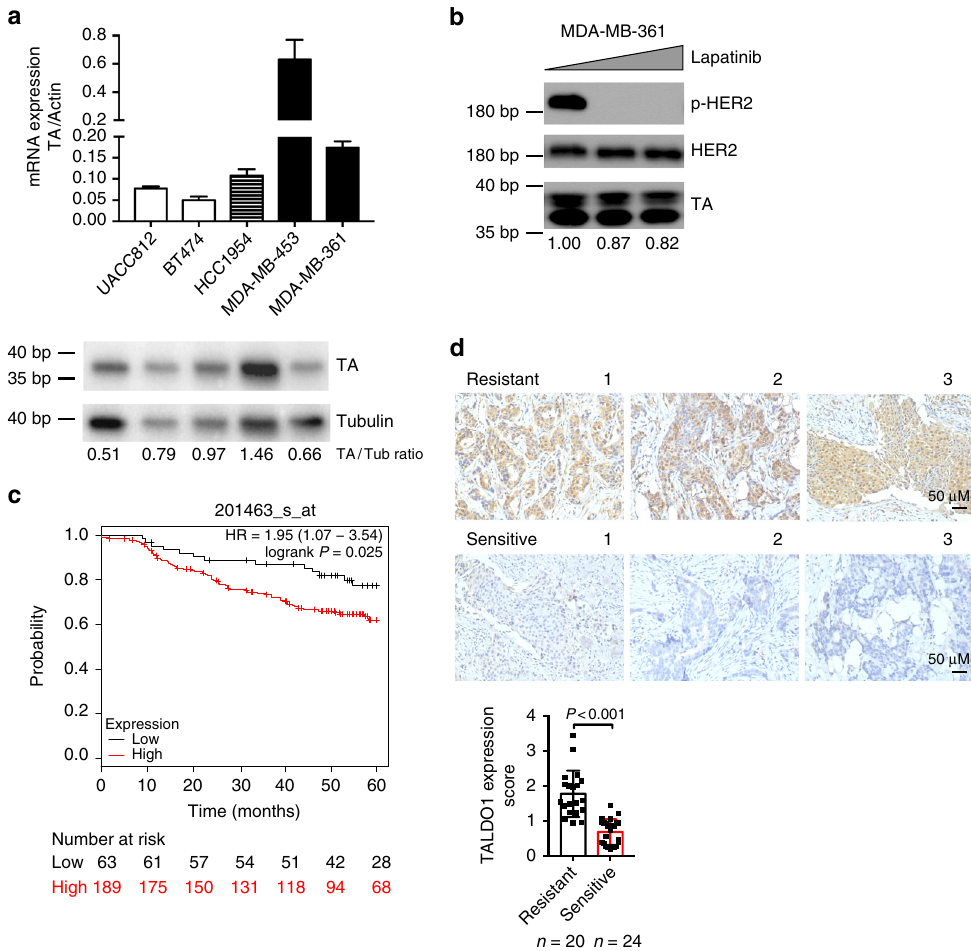
Fig. 3 TA expression correlates with sensitivity to lapatinib. a TA mRNA expression (normalized to actin, top) and protein expression (normalized to tubulin, bottom) of the indicated breast cancer cell lines was evaluated by RT-qPCR and western blotting, respectively. b Immunoblotting with indicated antibodies. MDA-MB-361 cells were treated with 0, 1, or 3 μ M lapatinib for 72 h and then collected. Band density was quanti fi ed using FIJI. c Kaplan – Meier relapse-free survival (RFS) analysis of HER2-ampli fi ed breast cancer patients strati fi ed by TA expression (TA-low quartile in black, remaining patients in red). d Representative TA immunostaining images in resistant (progressive or stable disease) and sensitive (partial remission or complete response) breast cancer tissues. Samples were obtained from HER2-positive breast cancers by core-needle biopsy prior to therapy. n = 24 resistant tumors and n = 20 sensitive tumors. Quanti fi cation of TA immunohistochemistry in resistant and sensitive tumors. Error bars denote the SD, P -value calculated with unpaired, two-tail, student t